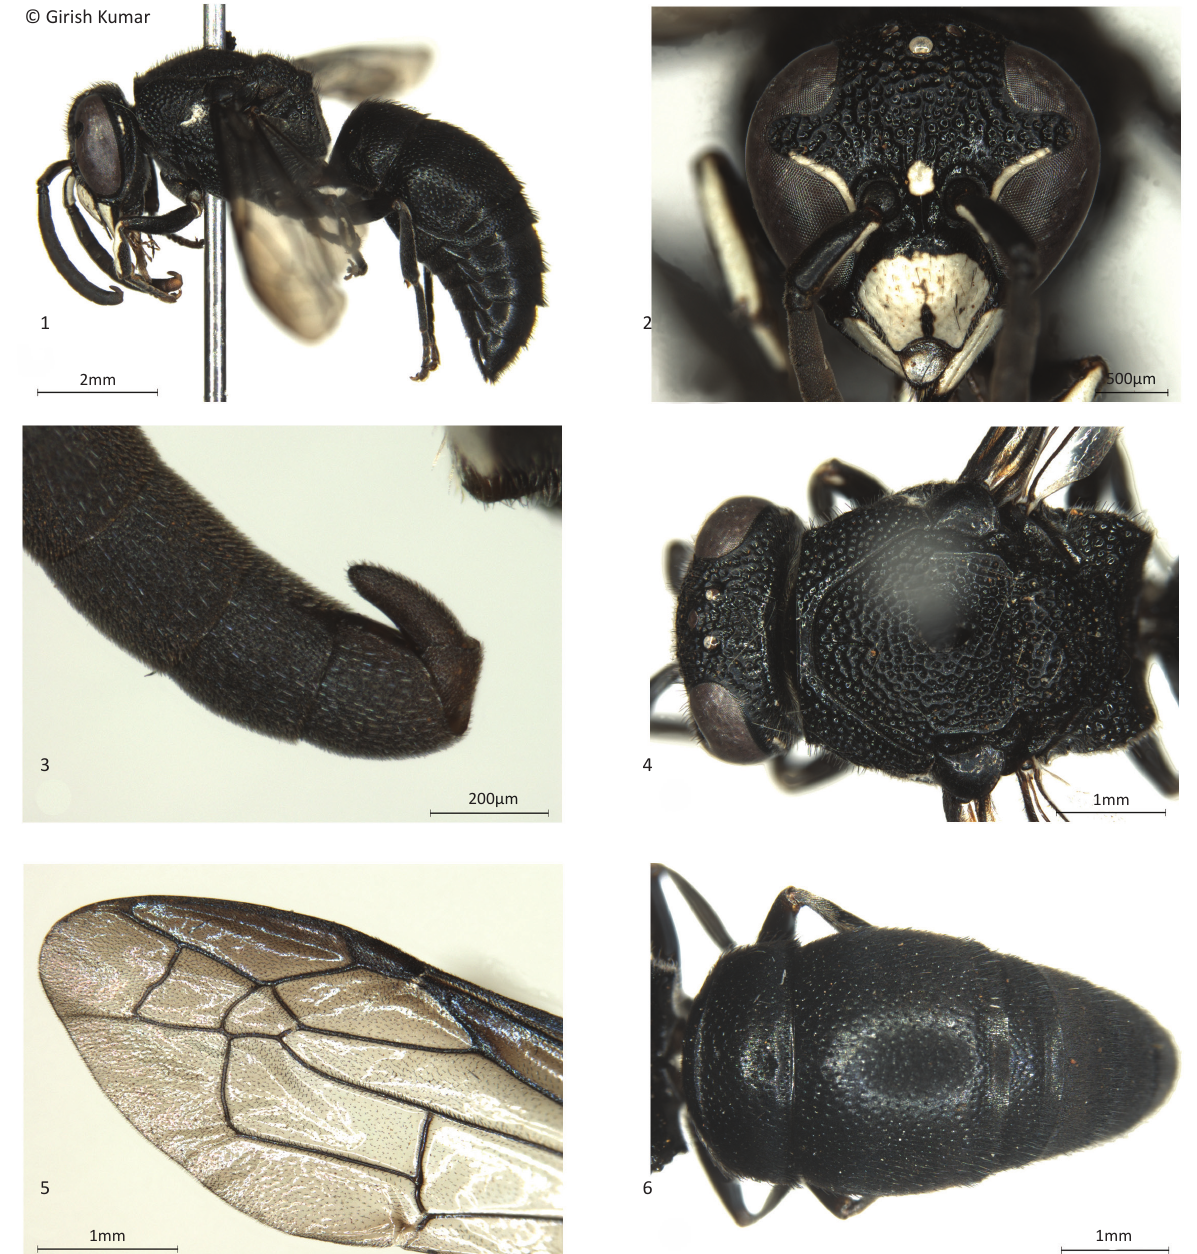
(H+M+T1+T2) 7mm; forewing length 7mm. Body black with white and yellowish-brown to blackish-brown markings. White markings: mandible except lateral and apical portions, a broadly rounded mark on labrum, clypeus except basal and lateral margins and a narrow vertical median line on lower half, interantennal spot, a narrow line on inner margin of eye from base of